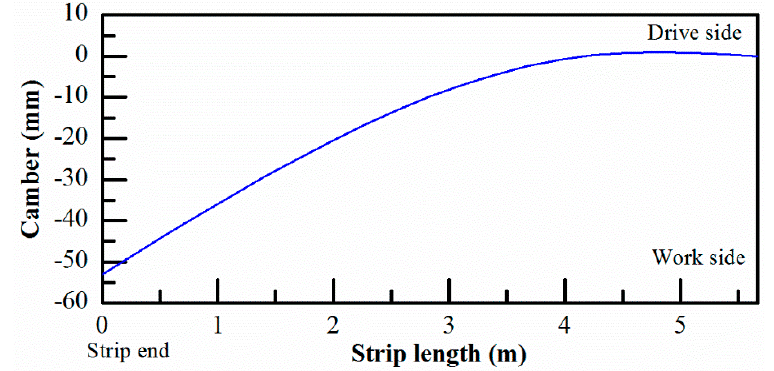
Figure 6. Center line profile of the strip model showing an initial strip end camber.